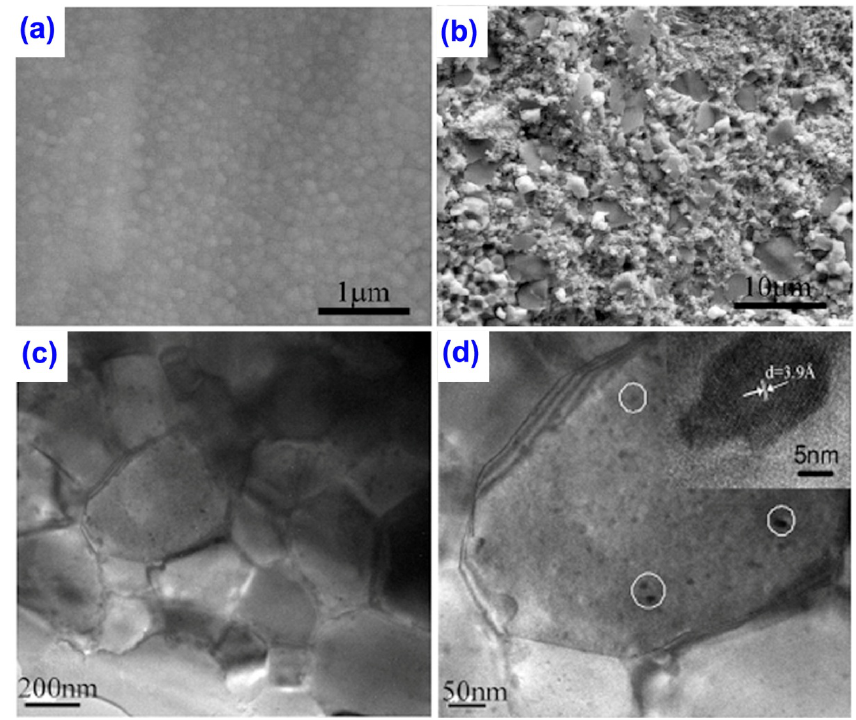
Zr NiSn Sb . TEM images of the MS Hf 0.6 0.4 0.98 0.02